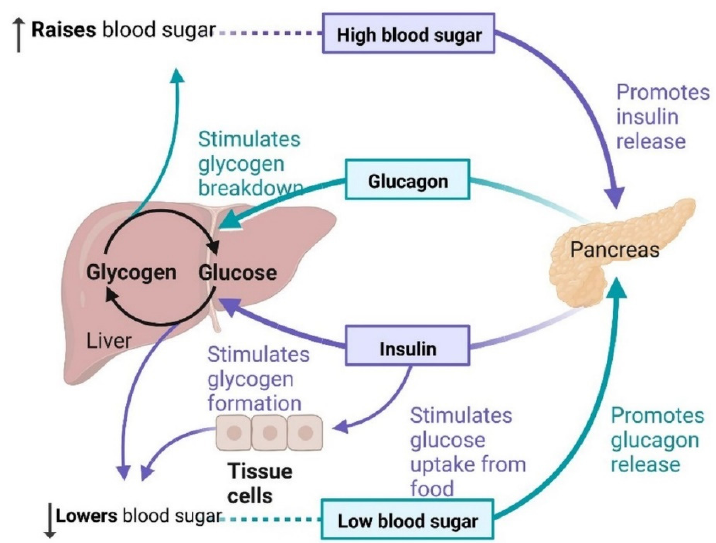
Figure 2. Regulation of blood glucose occurs through insulin.